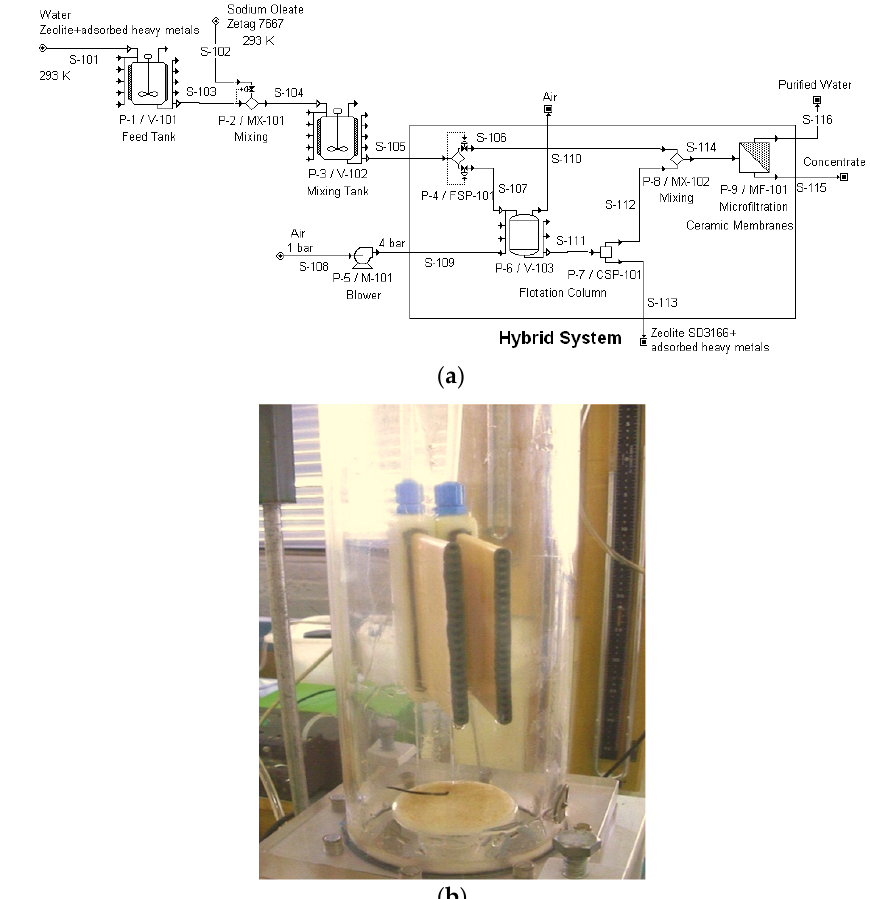
Figure 6. ( a ) Flowsheet for the techno-economical study for the hybrid system, applying adsorptive flotation. ( b ) A close-view photograph of the hybrid cell at the laboratory. Reprinted with permission; copyright Elsevier [34].